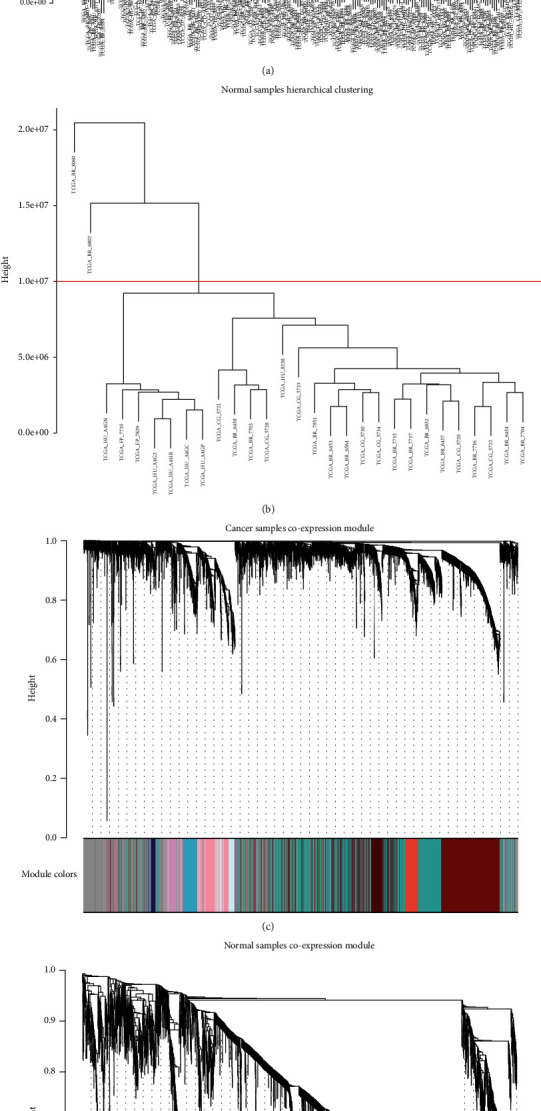
WGCNA analysis results. (a) Hierarchical clustering results of cancer samples (gastric cancer) (cut off = 0.5e06); (b) hierarchical clustering results of normal samples (gastric cancer) (cut off = 1e06); (c) cancer samples coexpression module (72 gene modules, except grey module); (d) normal samples coexpression module (36 gene modules, except grey module).